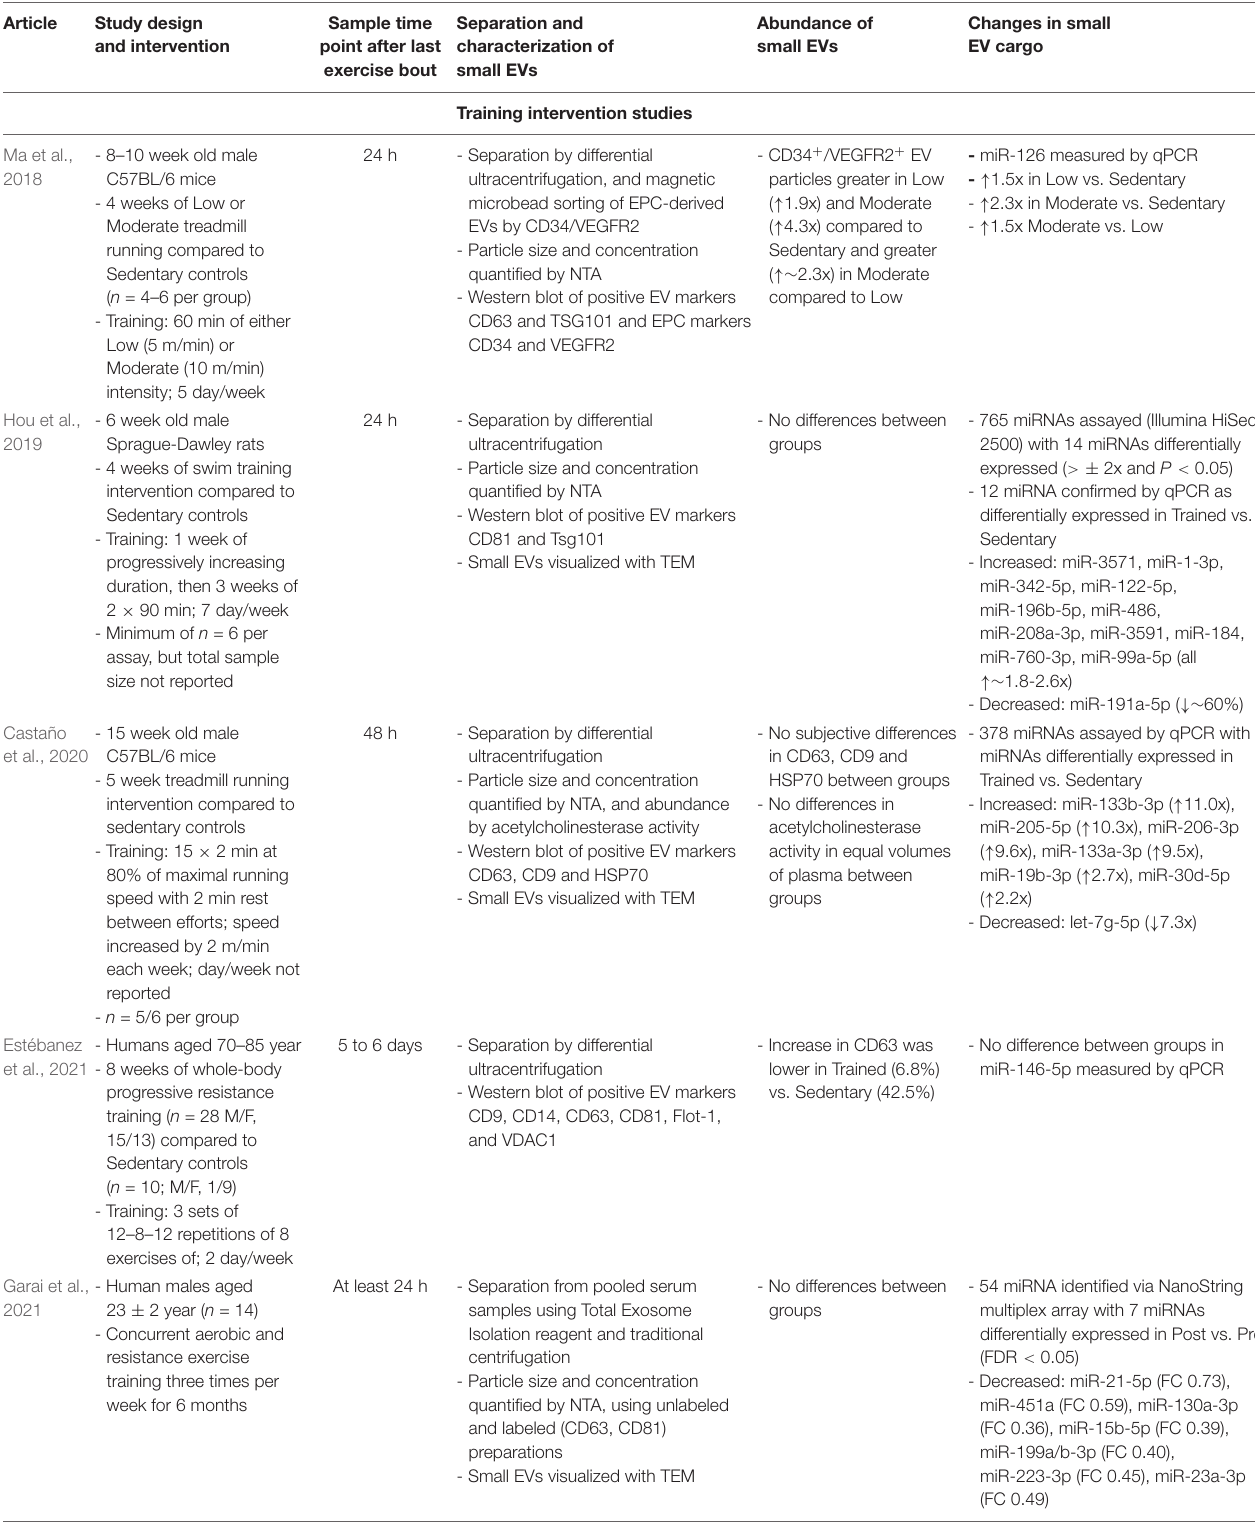
TABLE 2 | Studies in rodents or humans that have investigated the effect of exercise training on the profile of circulating small EVs either by examining the response to exercise training interventions or by performing cross-sectional comparisons of trained and untrained